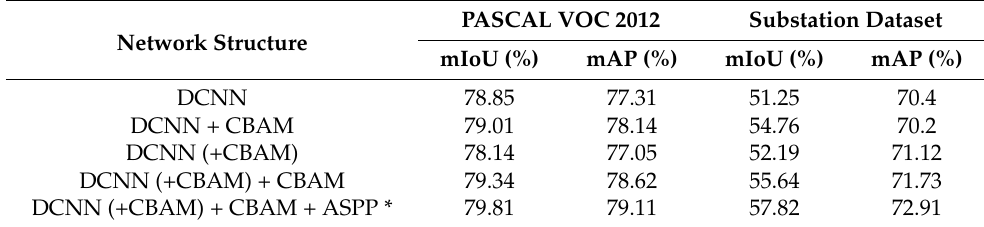
Table 3. MAP and mIoU test results by